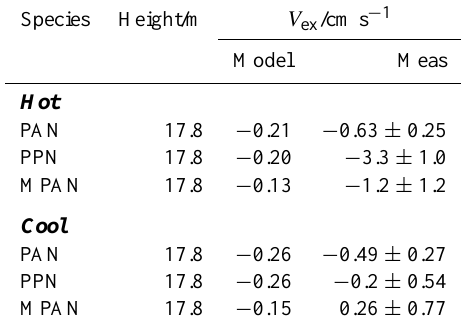
departure from PAN, becoming positive above z/h = 0 . 3.